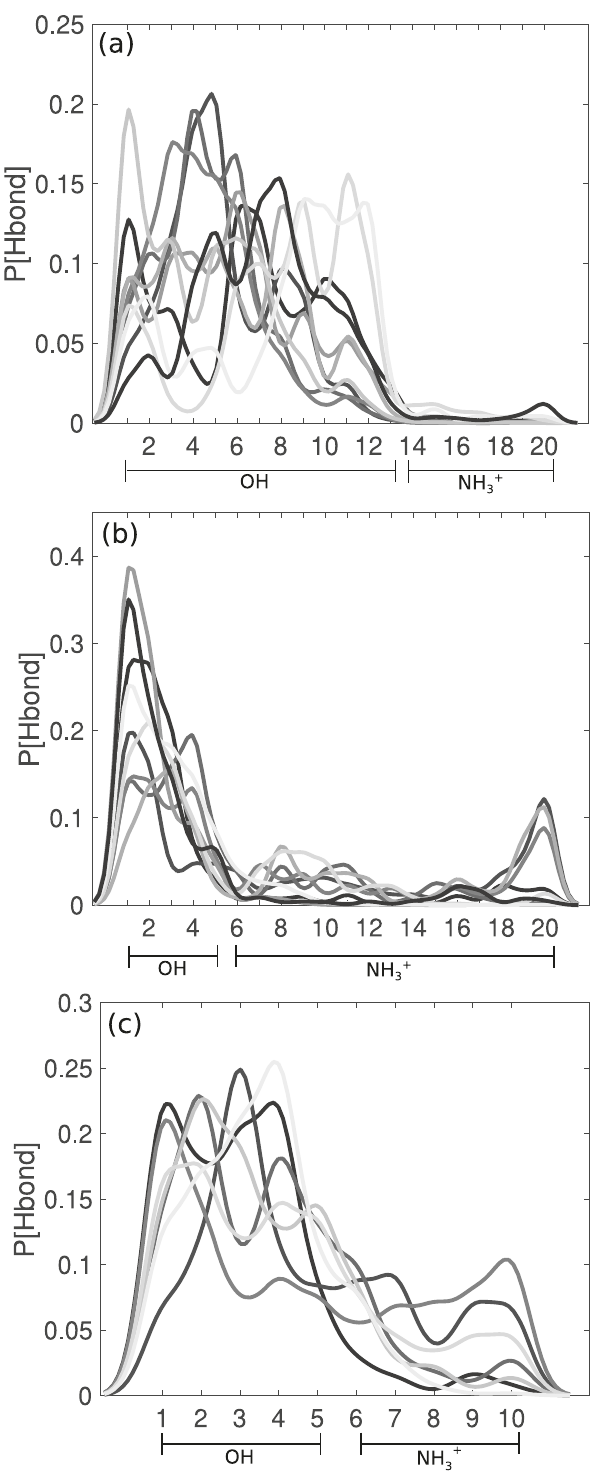
Fig. 10 Hydrogen bonding between PVA-b-PVAm block copolymers and ice. a Probability density functions of the number of hydrogen bonds between the -OH or -NH þ functional groups and the ice surface in the case 3 of PVA 13 - b -PVAm 7 . b Same as a but for PVA 5 - b -PVAm 15 . c Same as a but for PVA 5 - b -PVAm 5 . The results have been averaged over 10 statistical independent MD